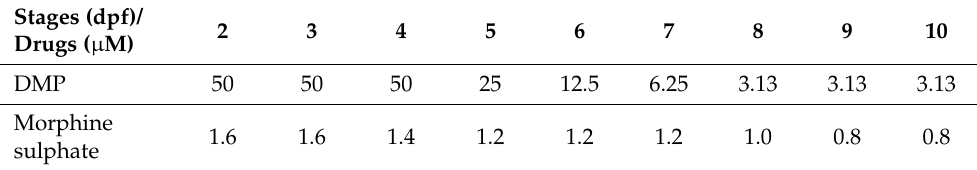
Table A1. The highest concentration of drugs at different developmental stages of the embryo.